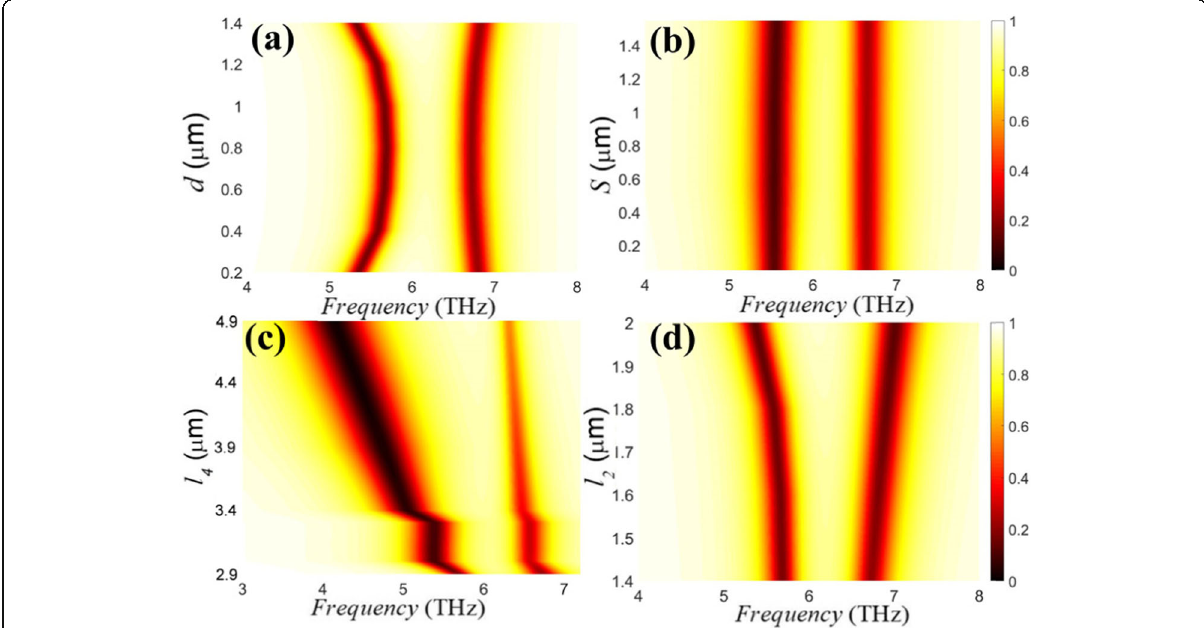
Fig. 6 Transmission spectra dependence on different geometric parameters. a The coupling distance, d , ( b ) the lateral displacement, S , ( c ) the length of graphene strip, l 4 , ( d ) the width of graphene strip, l